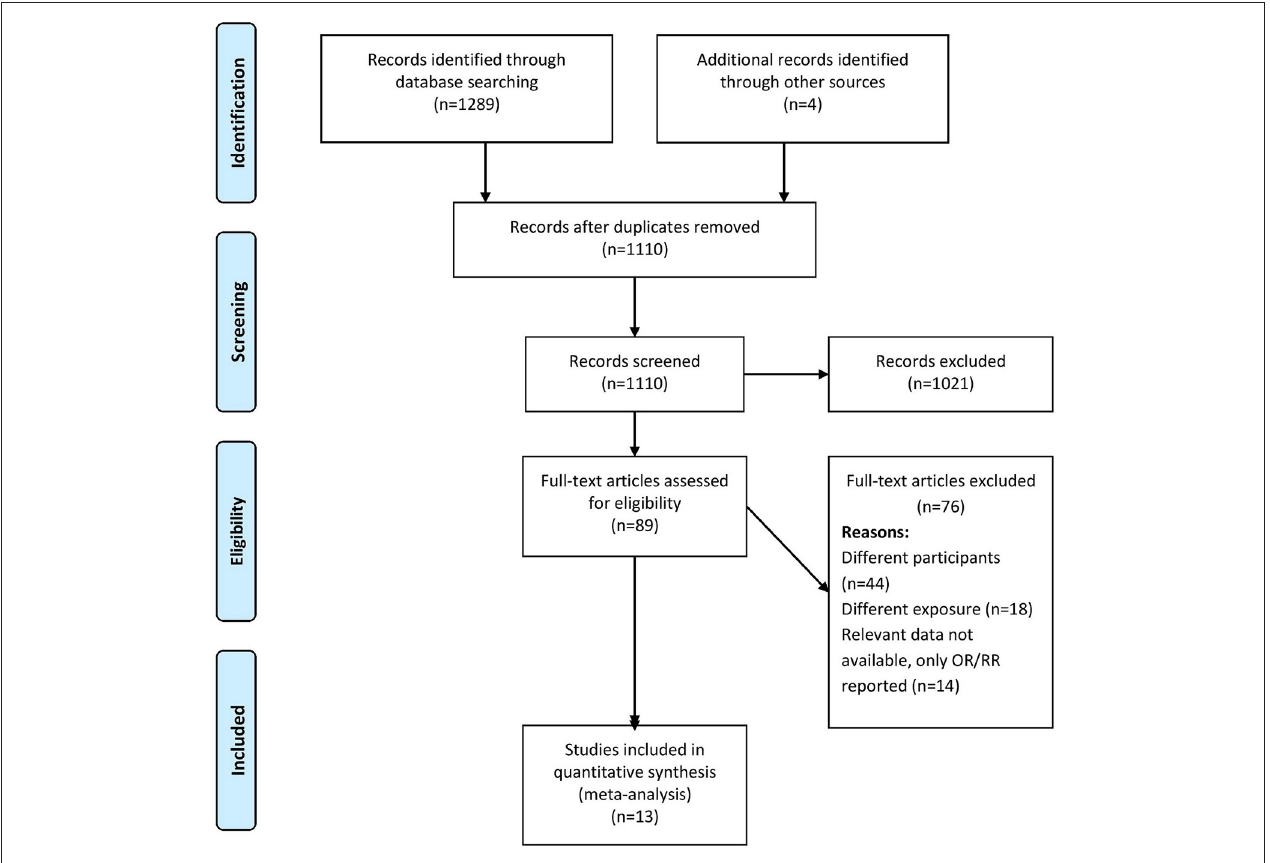
FIGURE 1 | PRISMA flowchart ( n